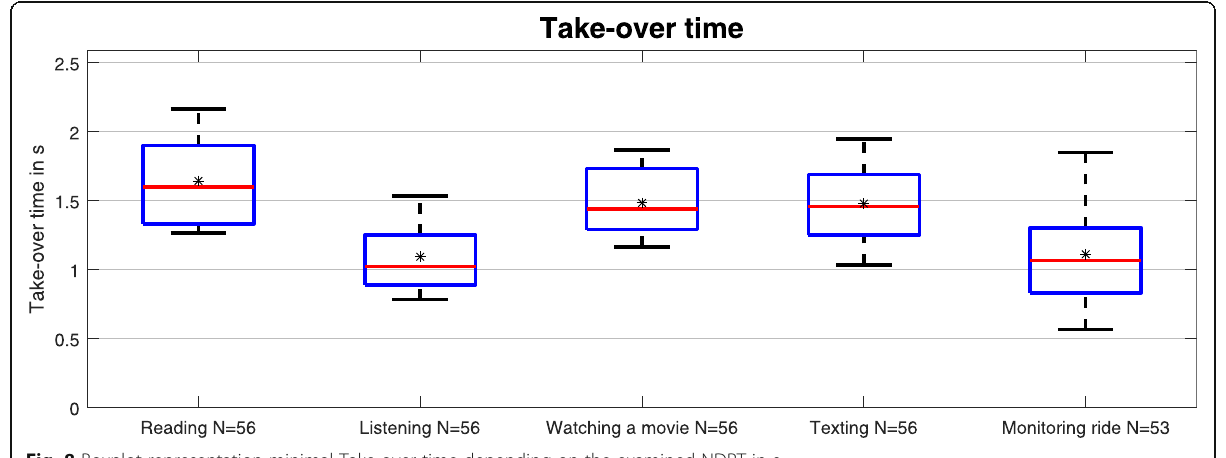
Fig. 8 Boxplot representation minimal Take-over time depending on the examined NDRT in